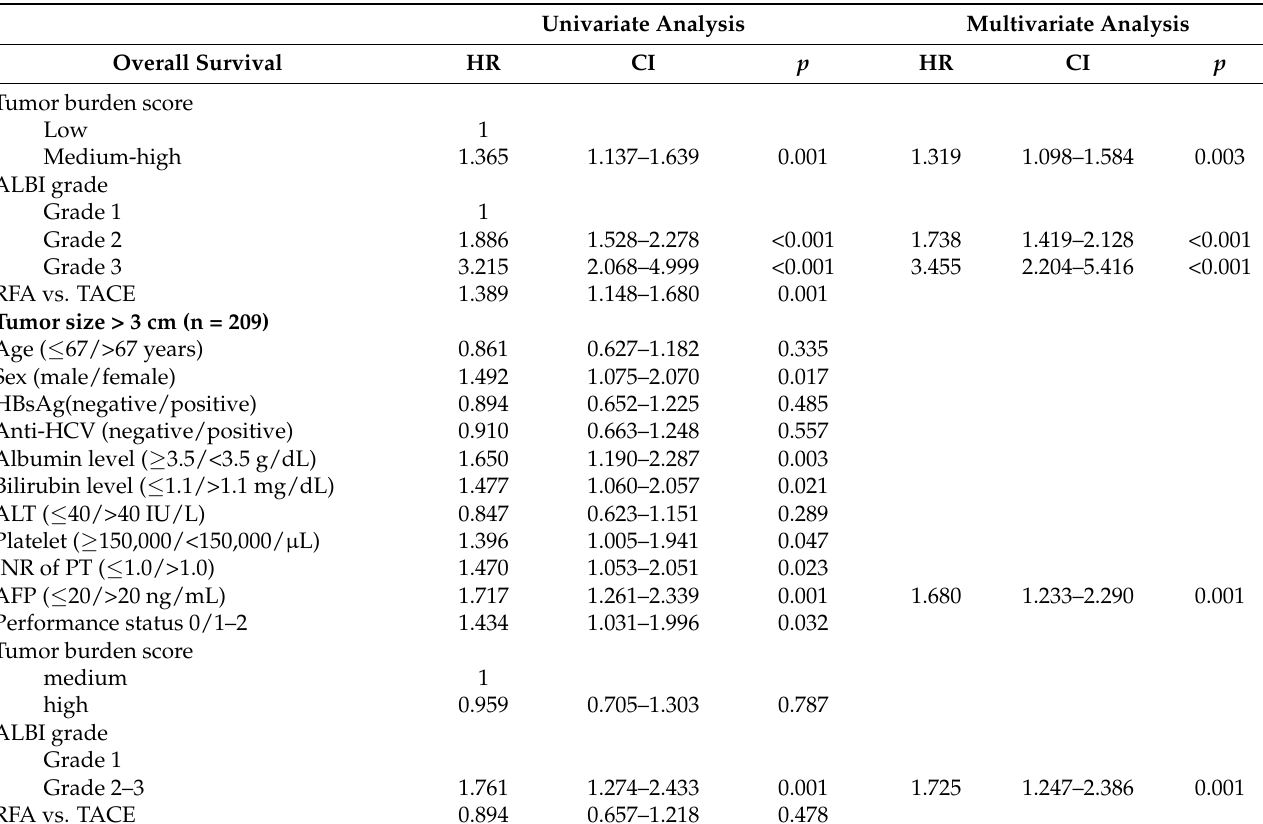
Table 5. Cont. Univariate Analysis Multivariate